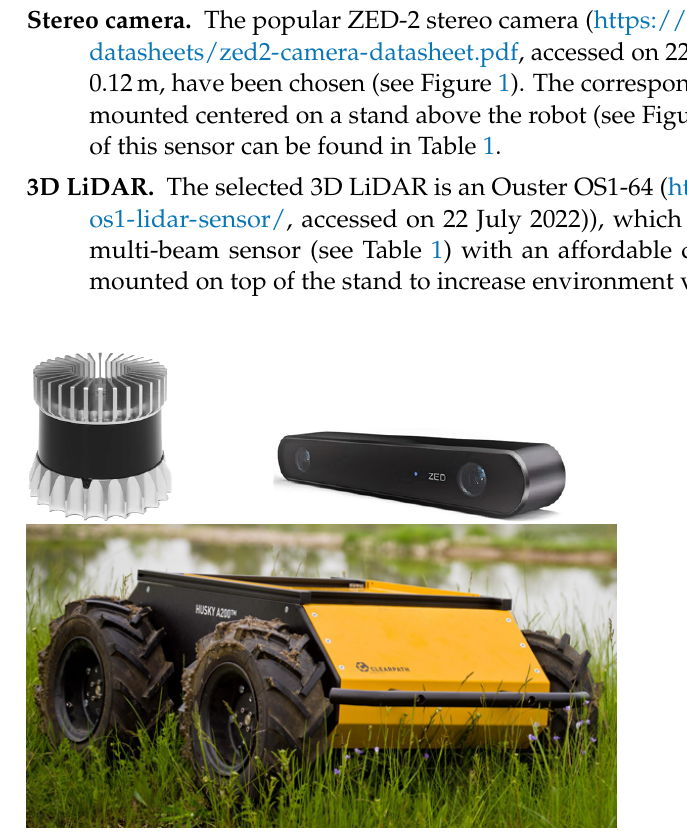
Figure 1. Photographs of an Ouster OS1-64 LiDAR ( up-left ), a ZED-2 stereo camera ( up-right ) and a Clearpath Husky UGV ( down ).